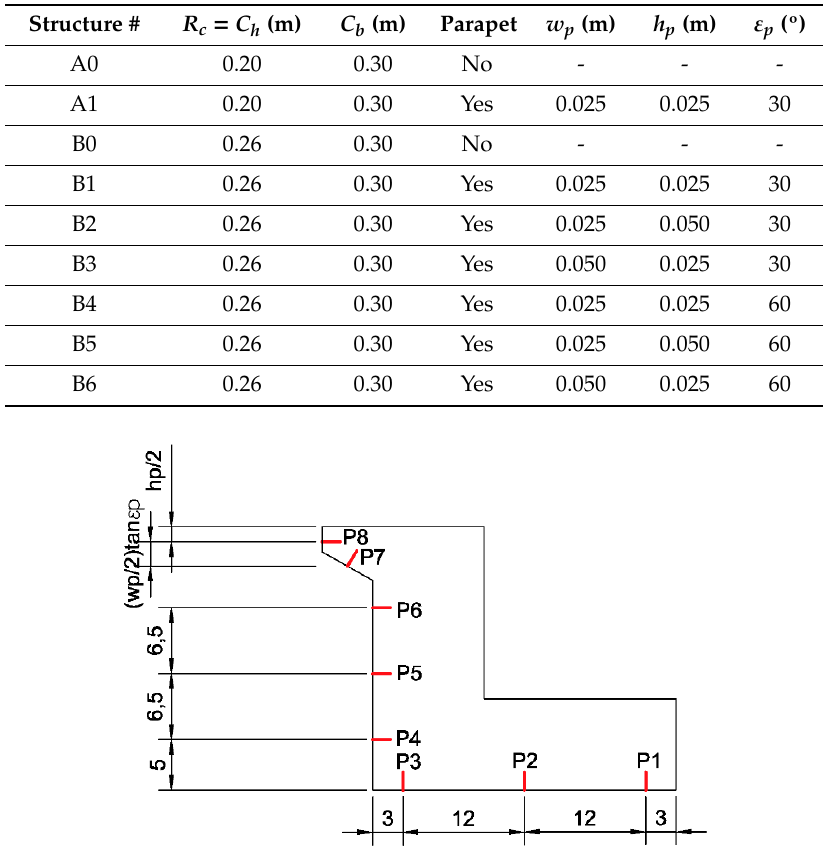
Table 2. Characteristic structures analyzed in the OpenFOAM ® model.